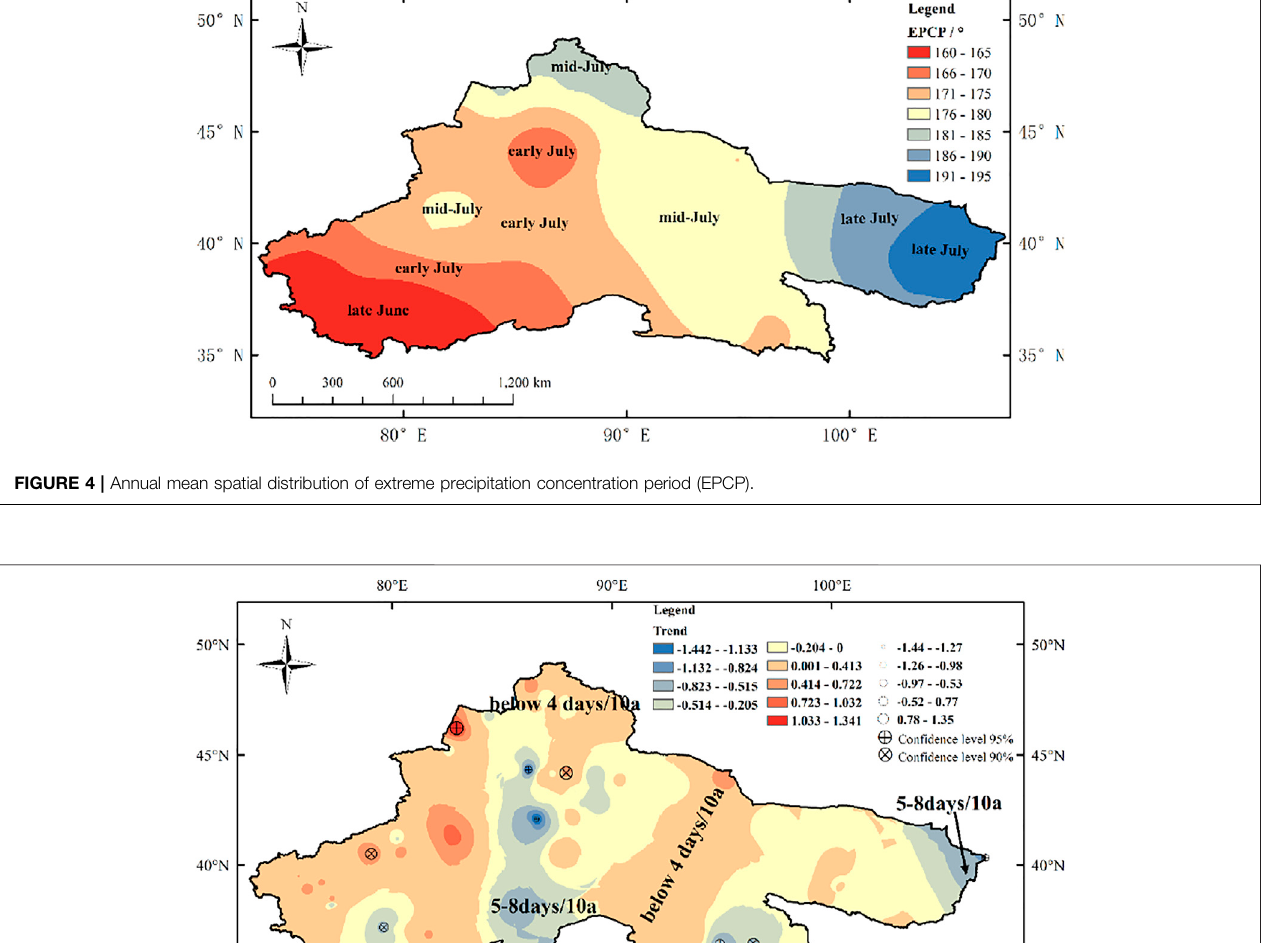
Frontiers in Earth Science |